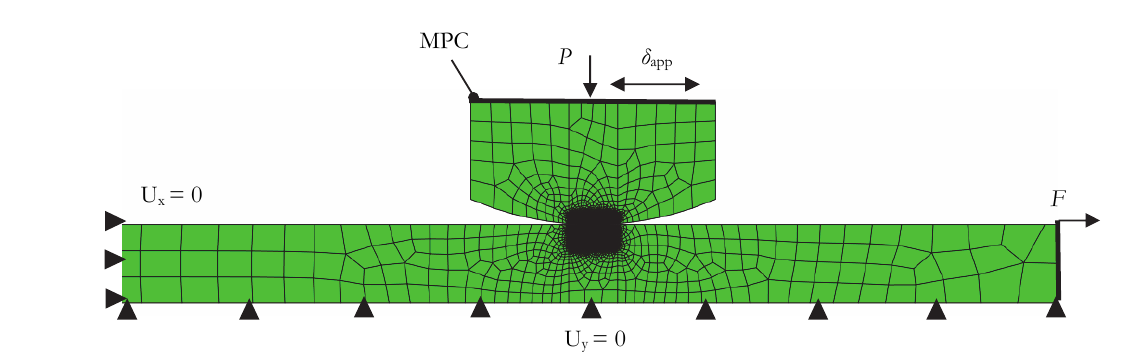
Figure 2: Boundary condition of the numerical model.